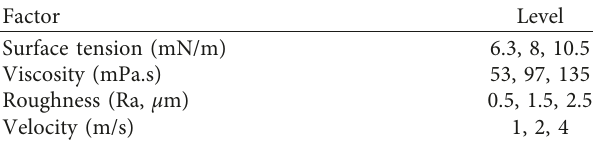
Table 1: Orthogonal design